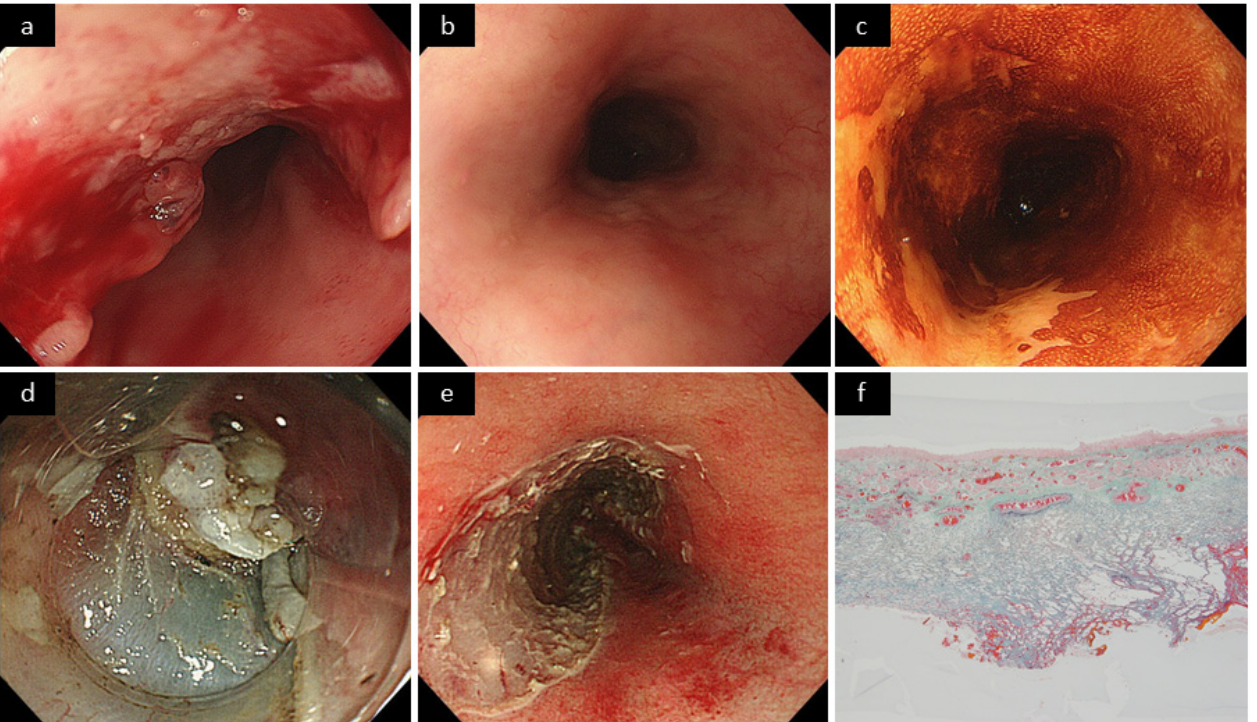
Figure 3. A representative case (Case 10). ( a ) An advanced squamous cell carcinoma (SCC) in the middle thoracic esophagus was seen. ( b ) After definitive chemoradiotherapy (dCRT), no tumor remnant was observed and a complete response was obtained. ( c ) Four years after the dCRT, recur- rence of half-circumscribed superficial esophageal SCC in the upper thoracic esophagus. ( d ) During endoscopic submucosal dissection (ESD), severe submucosal fibrosis was seen. The endoscopic F score was evaluated as 2. ( e ) ESD was completed without adverse events. As the mucosal defect was 3/4 circumference, a triamcinolone injection was performed to prevent stenosis. ( f ) Histopathological evaluation of the resection specimen showed severe submucosal fibrosis, with a pathological fibrosis score of 2.